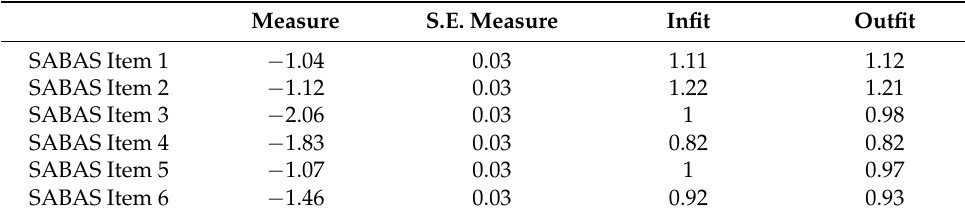
Table 6. Item statistics from partial credit polytomous Rasch model.